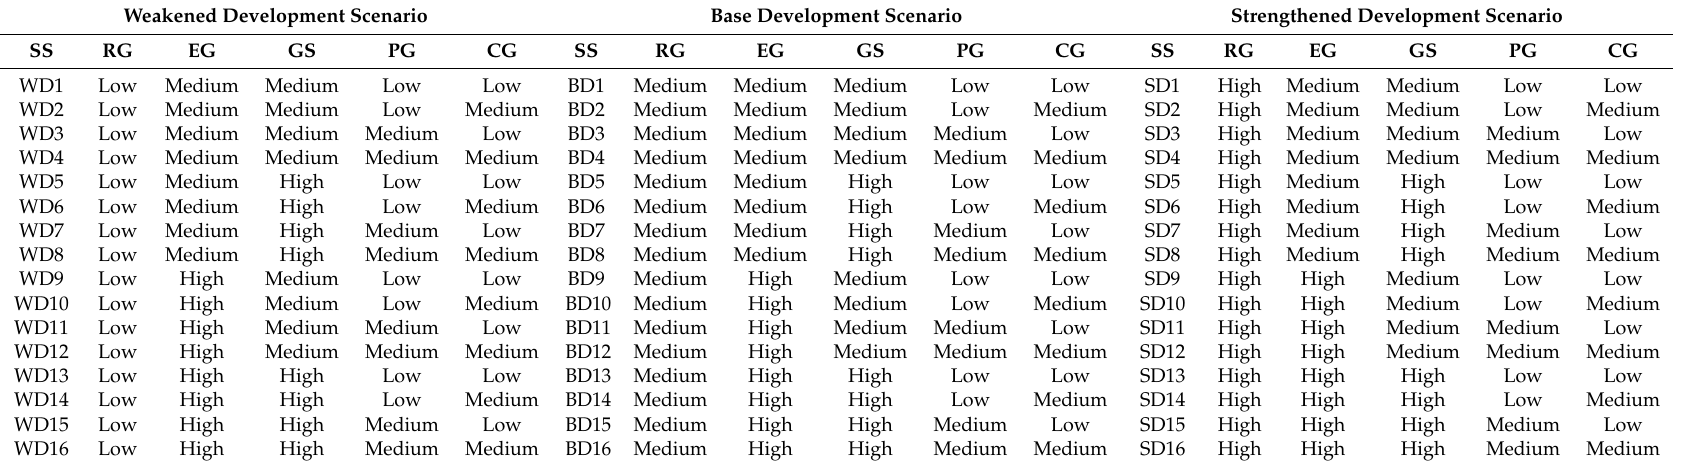
Table 7. Setting different development scenarios from 2018 to